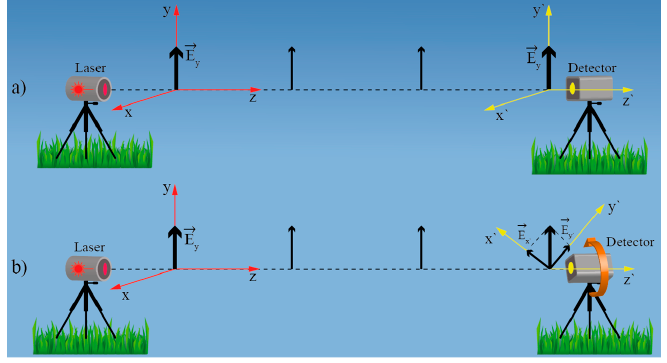
Figure 15. ( a ) E-field vector orientation remains unchanged during propagation through isotropic medium; ( b ) Rotation of the receiver rotates E-field vector in receiver’s local coordinate system.